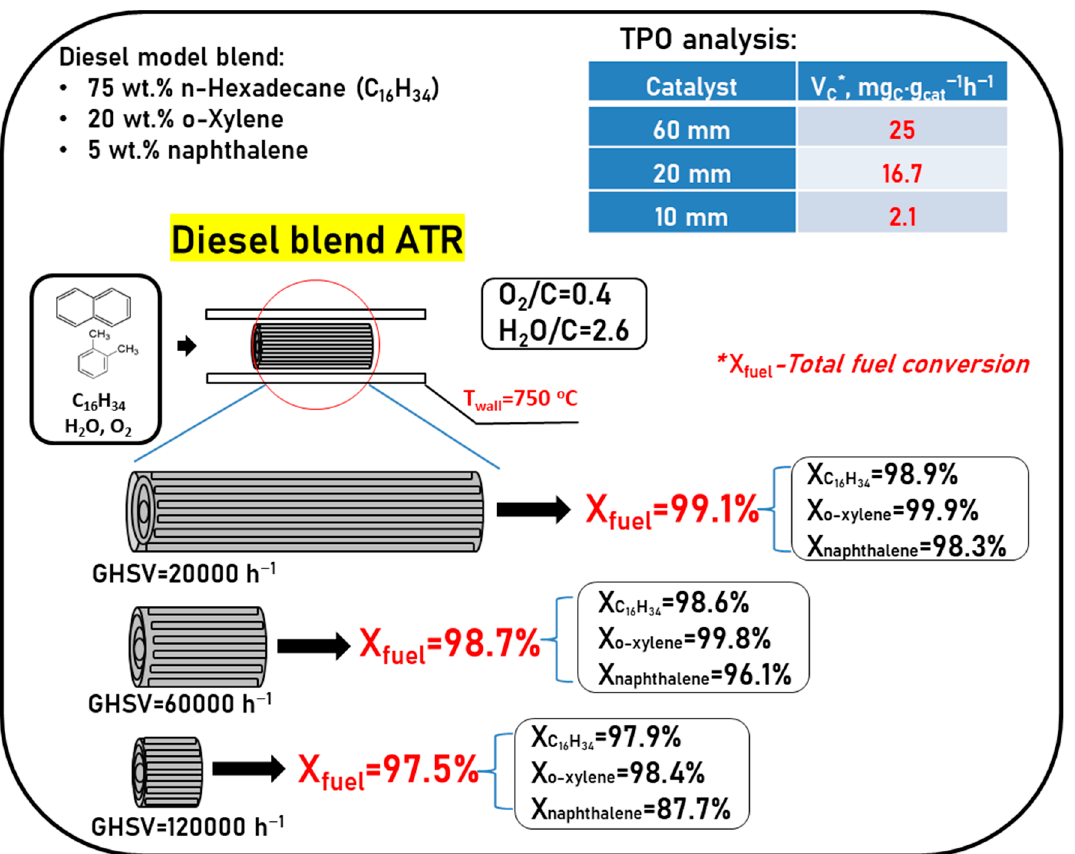
Figure 12. Autothermal reforming of DF model blend over Rh10, Rh20 and Rh60 at furnace temperature 750 °C. Adapted from [97].